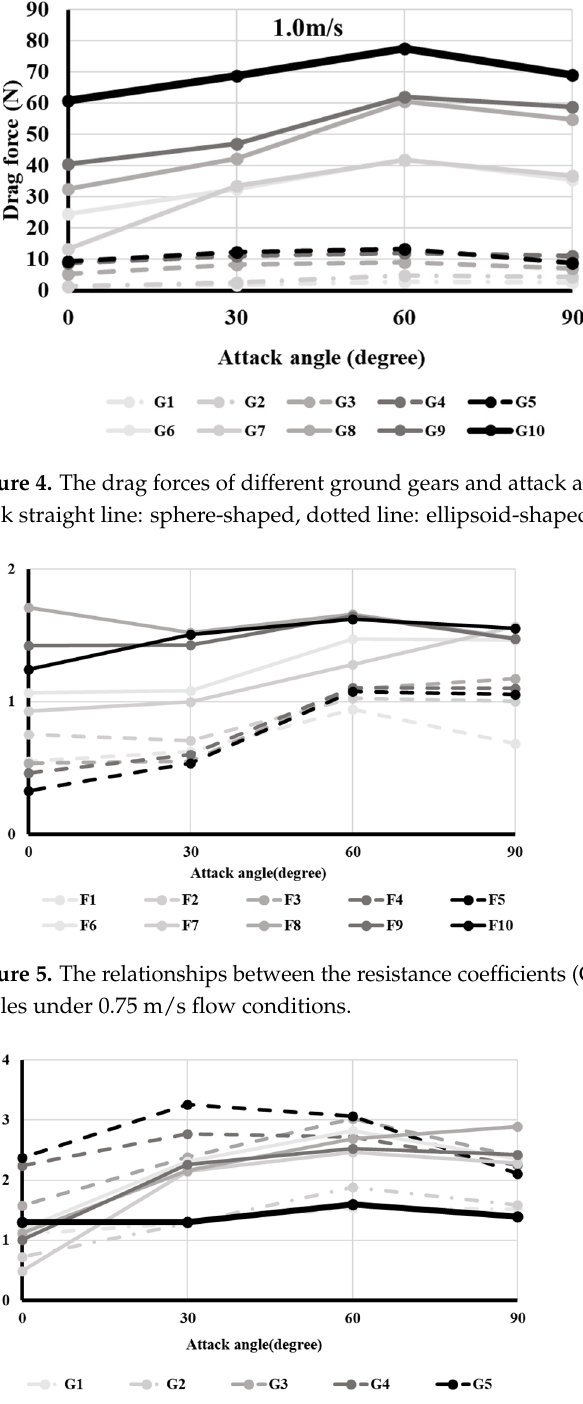
Figure 6. The relationships between the resistance coefficients (C D ) of the different ground gears (G1–G10) and their attack angles under 0.75 m/s flow conditions.